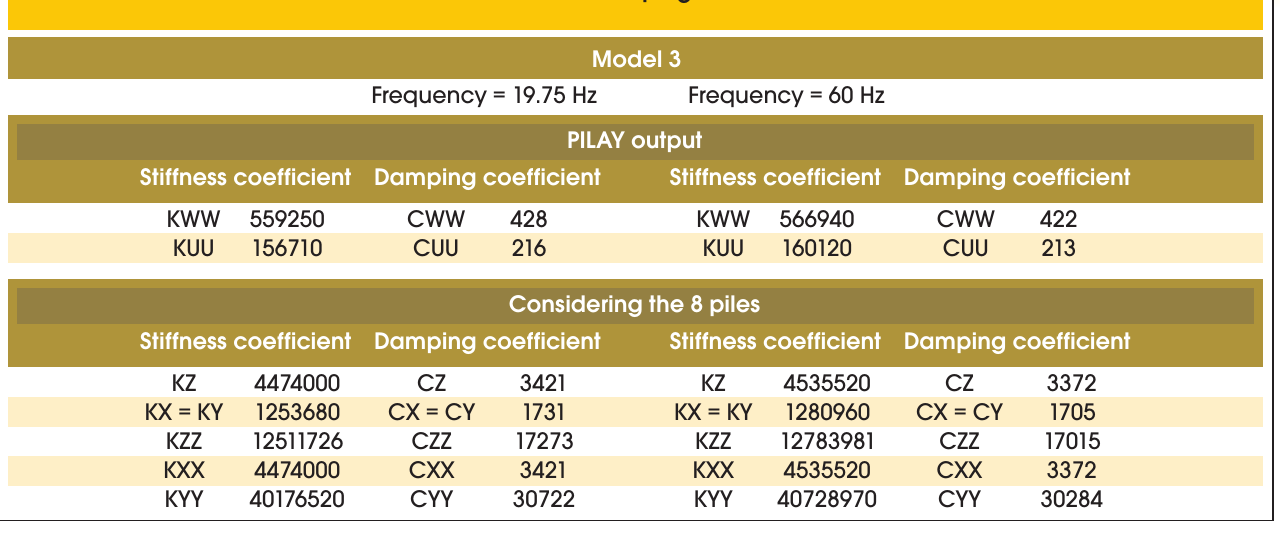
Table 10 – Stiffness and damping coefficients – Model 3